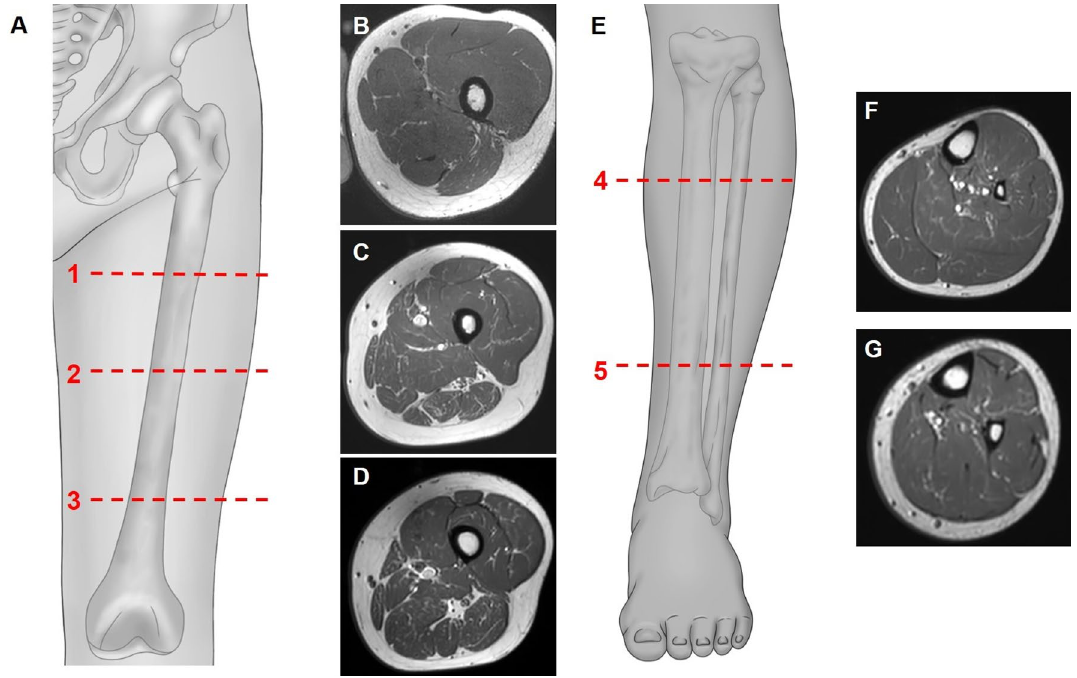
Figure 1. Illustrations ( A and E ) and axial ( B , C , D , F , and G ) T1-weighted images of the left lower extremity showing the levels where analyses were performed. A and E depict the levels where analyses were performed. Axial T1-weighted images of the thigh ( B , C , and D ) and lower leg ( F and G ) where gradings of the intramuscular fat infiltration using the Mercuri scale were performed: gluteus maximus tendon insertion ( B , level 1, proximal thigh); just inferior to the gluteus maximus inferior margin ( C, level 2, mid thigh); just inferior to the adductor longus inferior margin ( D , level 3, distal thigh); just inferior to the popliteus inferior margin ( F , level 4, proximal lower leg); and the uppermost part of the gastrocnemius tendon ( G , level 5, distal lower leg). Illustrations ( A and E ) were made using Adobe Photoshop software version 21.0 ( Adobe Systems, San Jose,